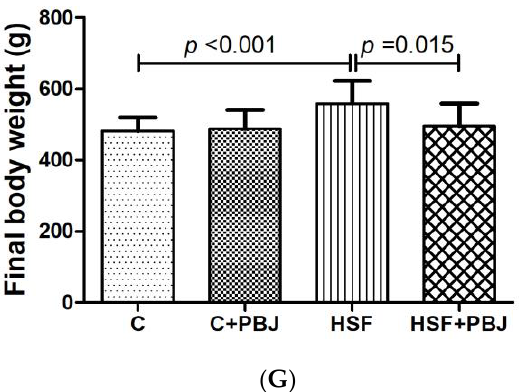
Figure 5. Metabolic syndrome parameters. ( A ) Glucose (mg/dL); ( B ) Triglycerides (mg/dL); ( C ) TyG; ( D ) Systolic blood pressure (mmHg); ( E ) Visceral adipose tissue (g); ( F ) Adiposity index (%); ( G ) Final body weight. The data are expressed as mean ± standard deviation (SD) or medians (interquartile range). Comparison by two-way ANOVA with Tukey’s post-hoc. TyG—Fasting triglycerides and glucose index. C—Control diet + placebo; HSF–High-sugar, high-fat diet; p < 0,05 as significant.